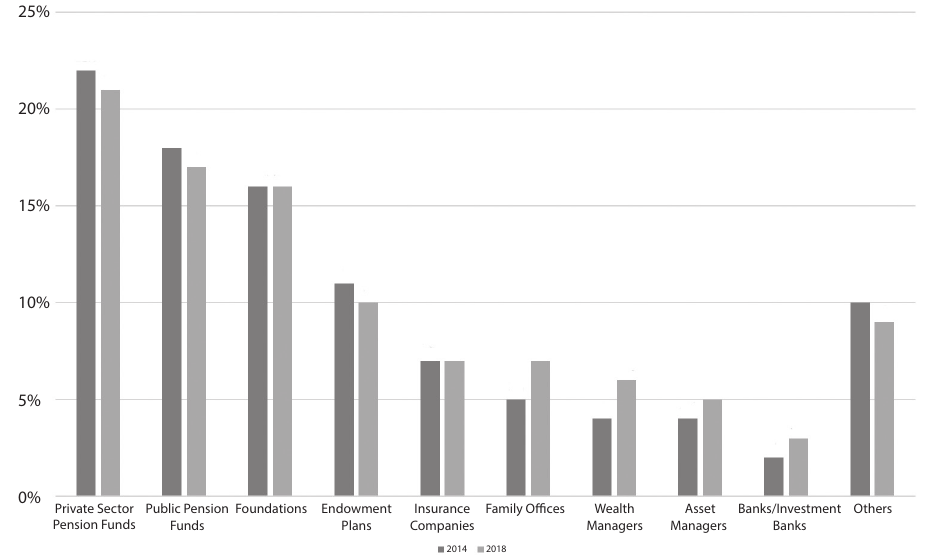
Figure 1. Institutional investors in real estate by type 2014 vs. 2018 (Preqin, 2020)